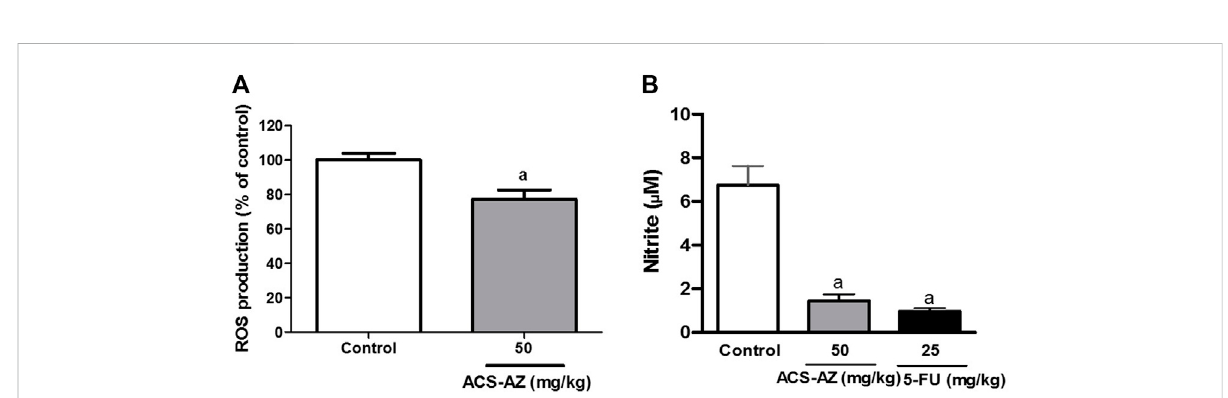
FIGURE 5 Effect of a 7-day treatment with ACS-AZ (50 mg/kg) or 5-FU (25 mg/kg) by intraperitoneal route on Reactive Oxigen Species — ROS (% of control) (A) and nitrite (µM) (B) quanti fi cation from the ascitic fl uidof Ehrlich ascites carcinoma-bearing mice. The results represent the mean ± SEM ( n = 8) analyzed by Student ’ s t-test for DCFH-DA assay, and one-way ANOVA followed by Tukey test for Griess assay: a p < 0.05 vs. control. ACS-AZ: N ’ -(6-chloro-2-methoxyacridin-9-yl)-2-cyanoacetohydrazide; 5-FU: 5- fl